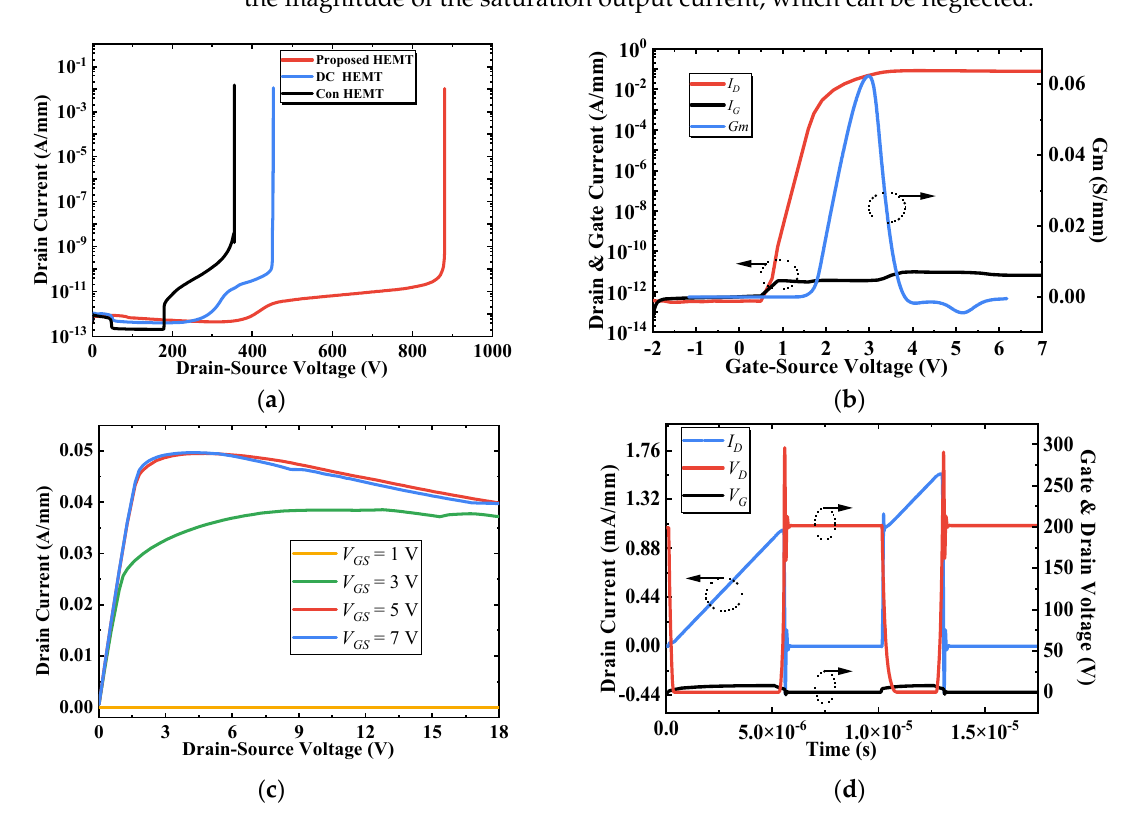
Figure 5. Electrical characteristics of devices. ( a ) Breakdown performance of Con, DC, and proposed BP-HEMTs. ( b ) Transfer and transconductance characteristics of BP-HEMT. ( c ) Output I D - V D characteristics of BP-HEMT. ( d ) Switching characteristics of BP-HEMT.